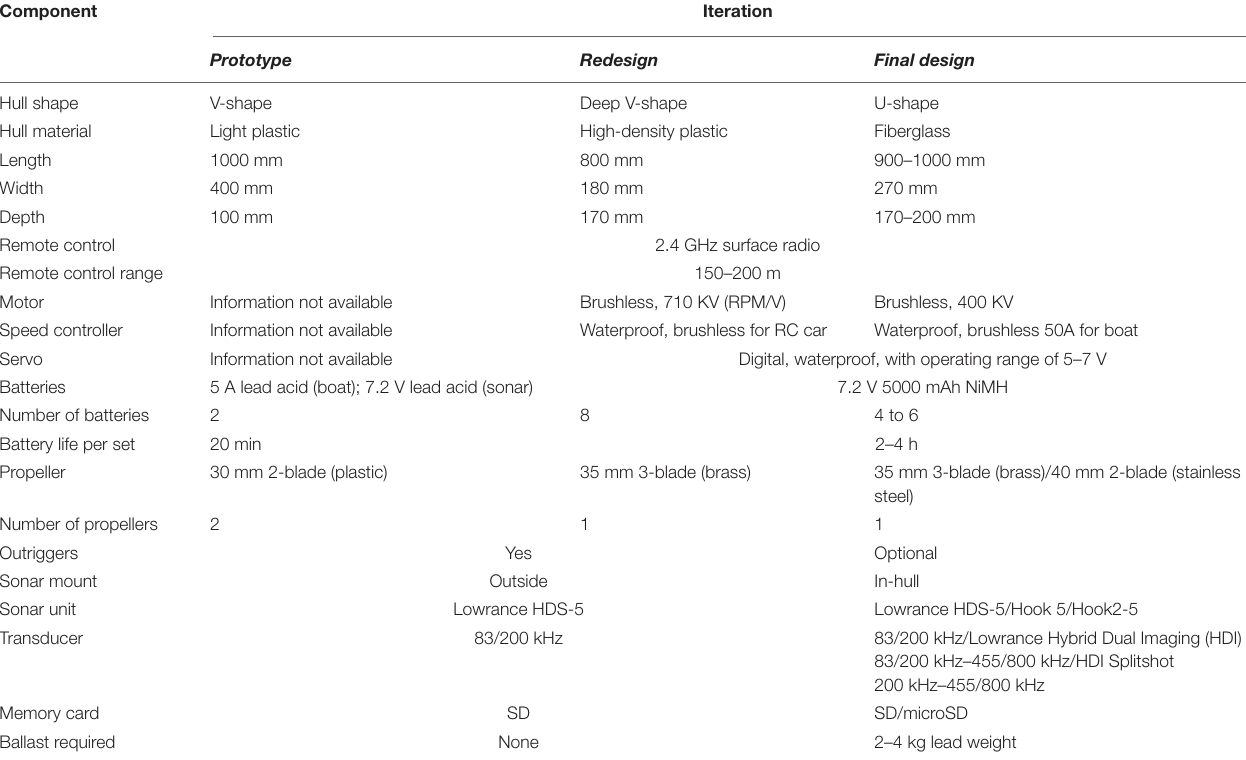
TABLE 1 | Specifications of the remote control boats built, showing their evolution from an off-the-shelf prototype ( Figure 2A ), to the redesign ( Figure 2B ), and finally to a robust and reliable shape ( Figure 2C